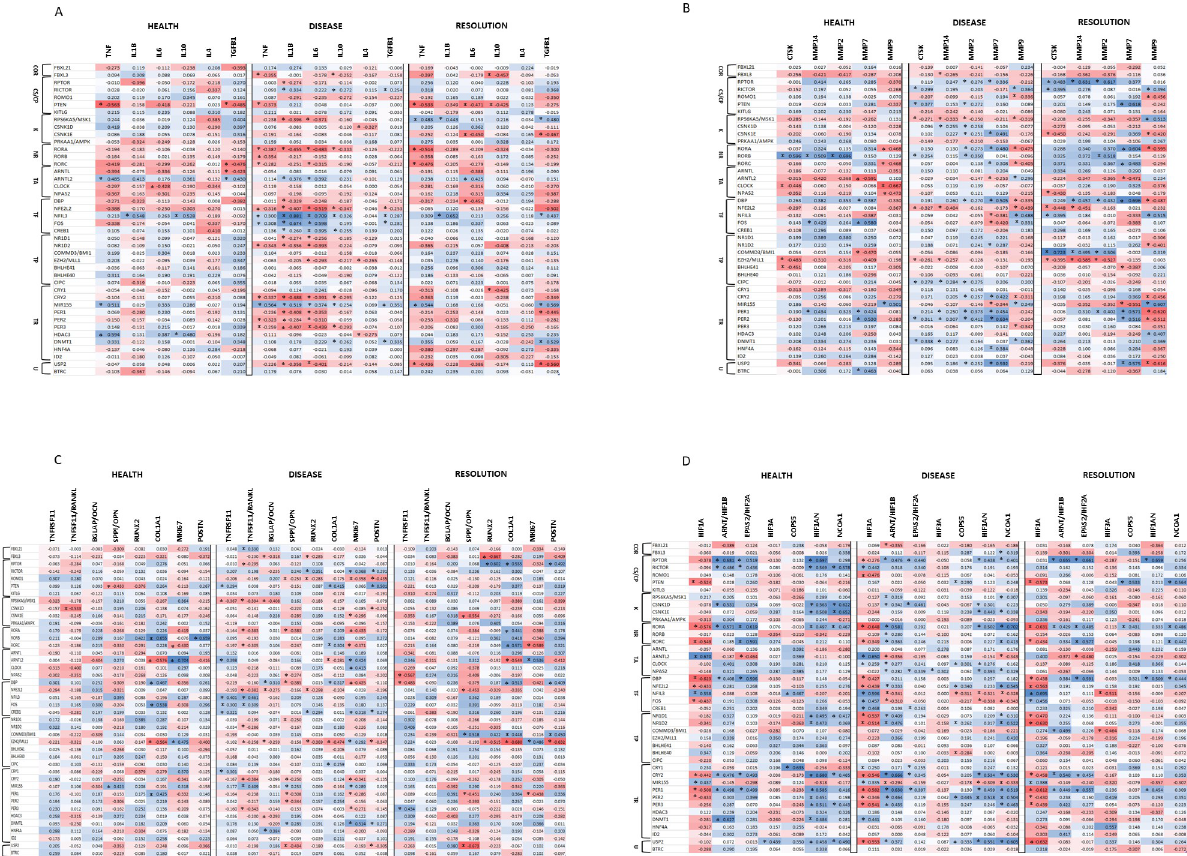
Fig 4. Circadian rhythm pathway gene expression profiles in health, disease, or resolution samples across all age groups correlated with inflammatory genes ( A ), tissue destructive/remodeling genes ( B ), bone biology genes ( C ), and hypoxia genes ( D ). Functional designation of the genes are as in Fig 1. Values denoted by asterisk ( � ) were significant at p <